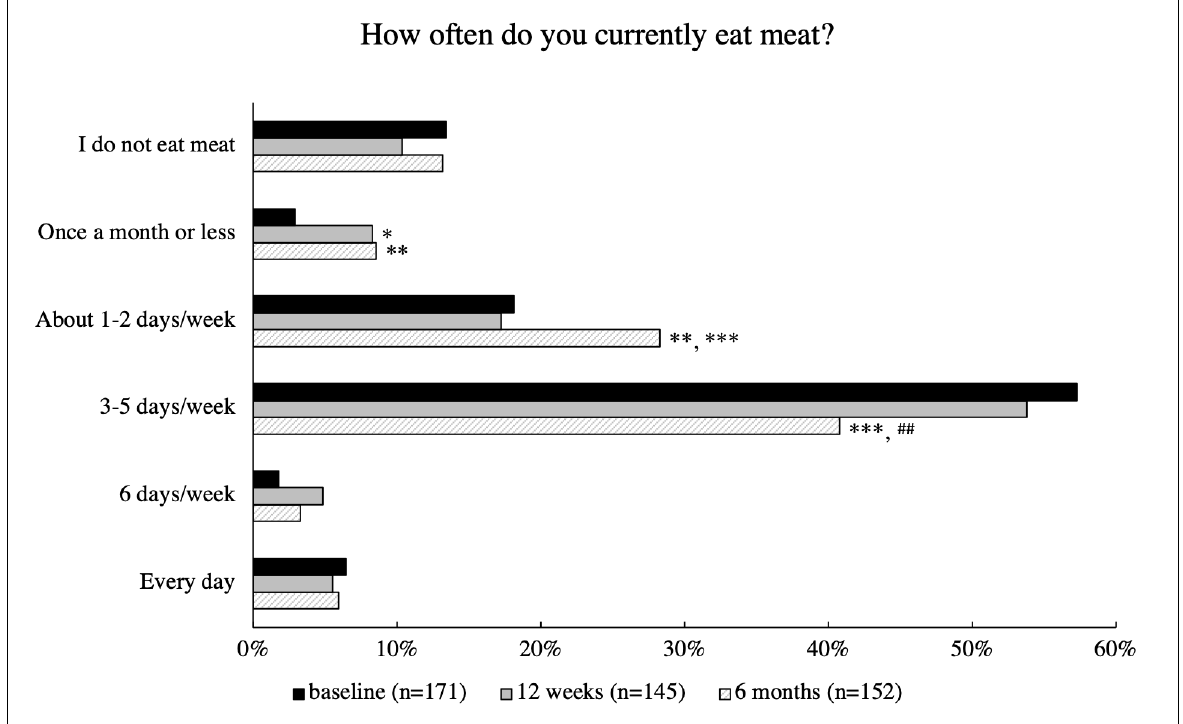
* denotes a significant difference ( p <0.05) between baseline and 12 weeks; ** denotes a significant difference (p<0.05) between baseline and 6 months post ( p <0.05); *** denotes a significant difference ( p <0.05) between 12 weeks and 6 months post; ## denotes a significant difference ( p <0.01) between baseline and 6 months post ( p